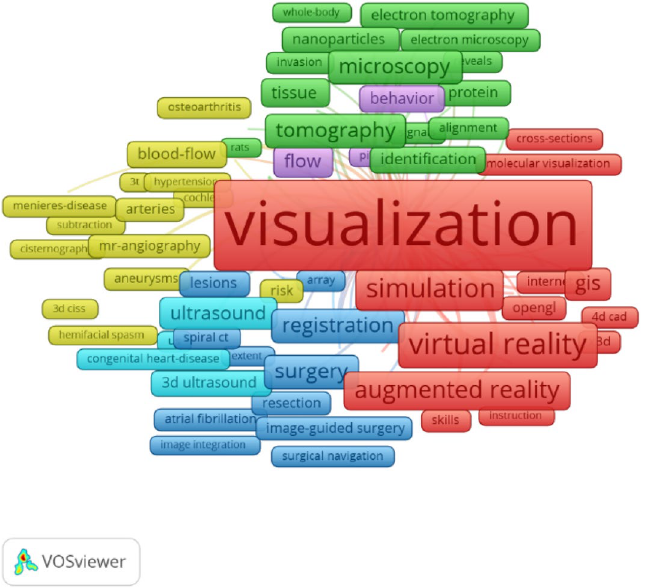
Figure 7. Analysis of keywords using the VOSviewer program (Holo-SDK 1.0 in Unity, https:// www. holo- sdk. com/) for the keyword “Visualisation 3D”. Source own study.